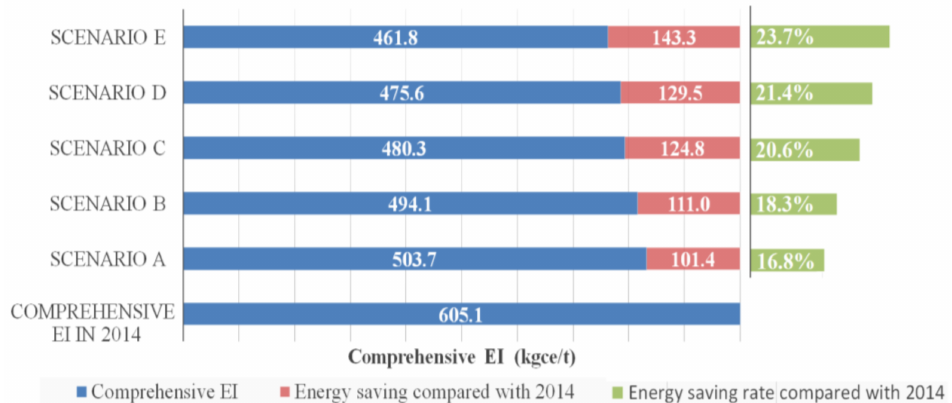
Figure 3. Energy saving potential in different scenarios (without considering coal consumption of power